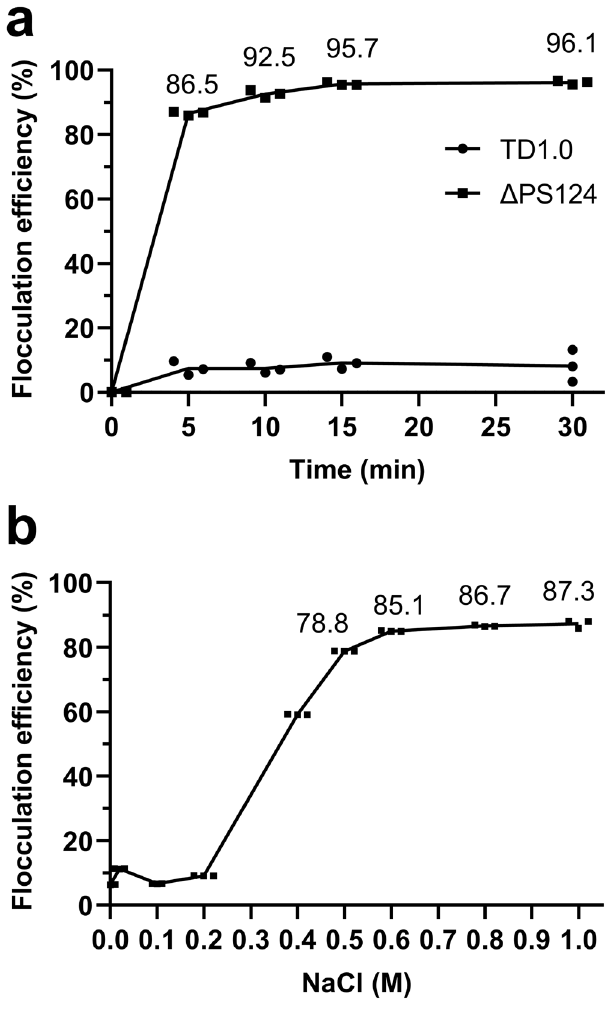
Fig. 3 Flocculation ef fi ciency of Δ PS124. a Flocculation ef fi ciency of TD1.0 and Δ PS124 in 60MMG medium containing 1 M NaCl. b Flocculation ef fi ciency of Δ PS124 cultured in 60MMG medium and resuspended in different concentrations of NaCl solution (0, 0.02, 0.1, 0.2, 0.4, 0.5, 0.6, 0.8, 1.0 M). Data are shown from three technical replications. Error bars represent SD ( n = 3). TD1.0, H . bluephagenesis TD1.0; Δ PS124, H . bluephagenesis TD1.0 with deletion of PS1, PS2, and PS4 gene clusters.